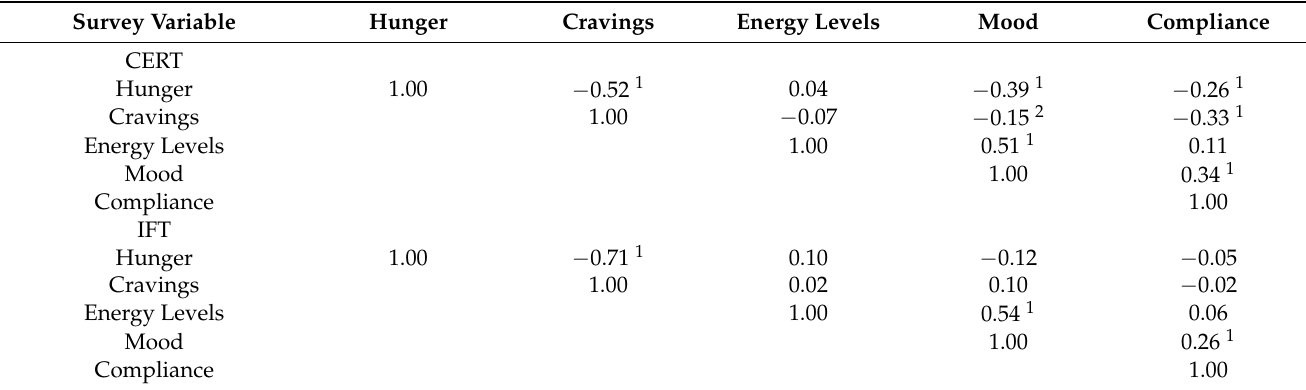
Table 7. Bivariate correlations between survey measures according to intervention